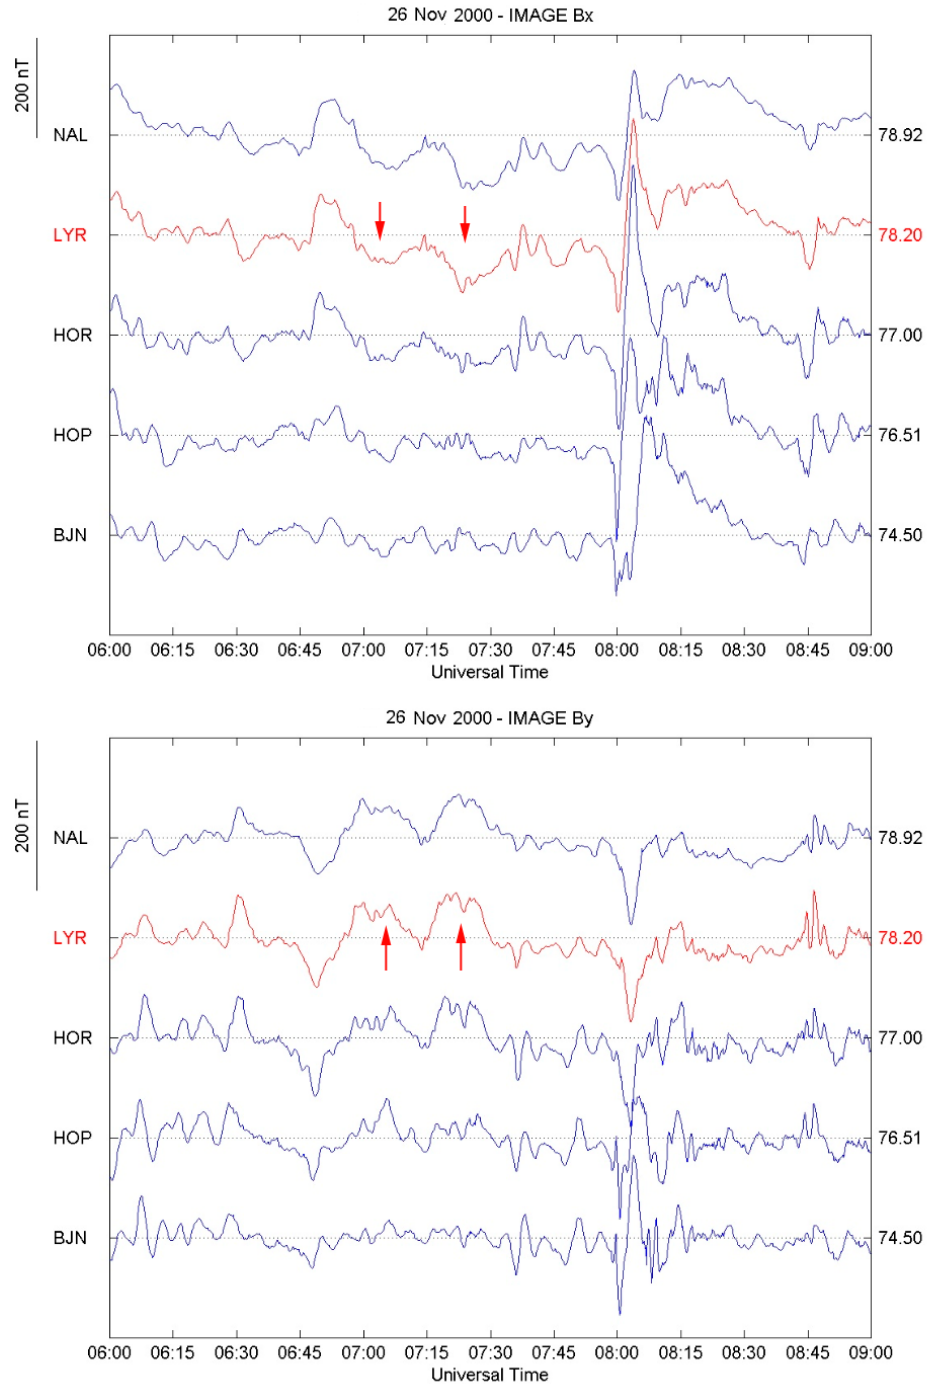
Fig. 3. Stack plot of the X - and Y -components of the ground magnetic field recorded at the following IMAGE stations: Ny ˚Alesund (NAL), Longyearbyen (LYR), Hornsund (HOR), Hopen Island (HOP) and Bear Island